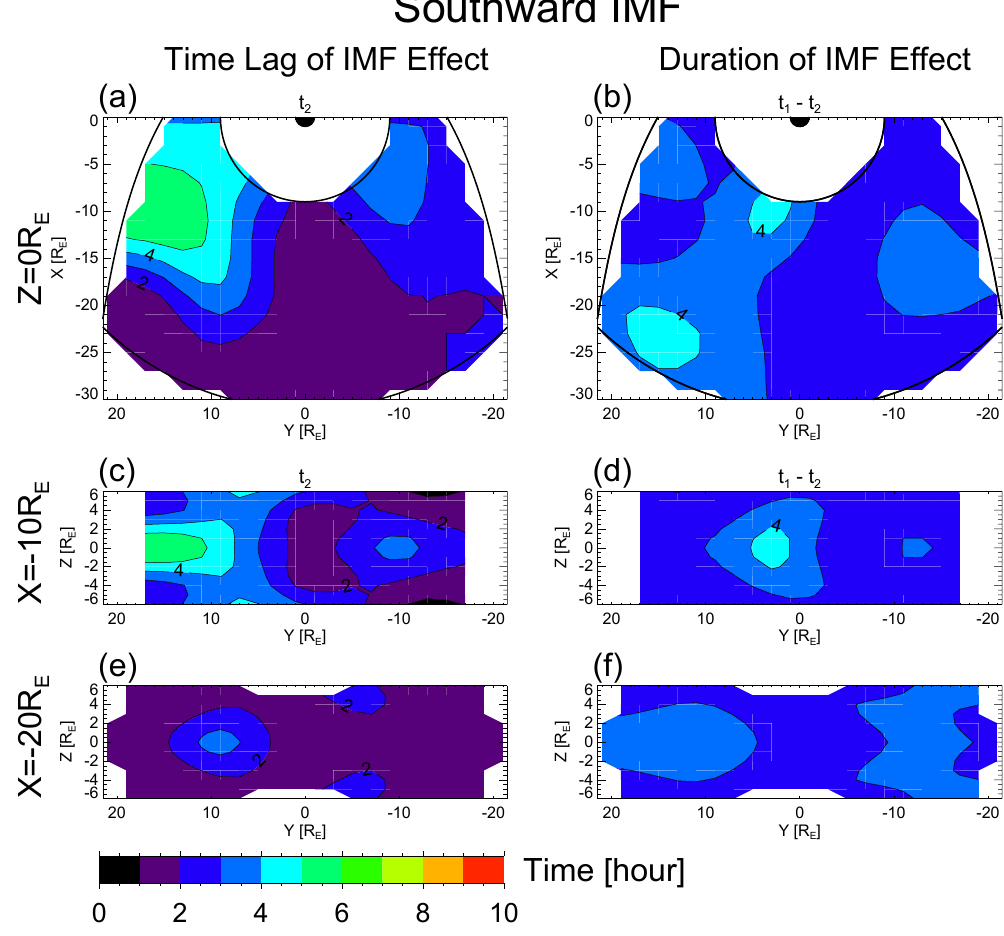
Fig. 9. Distributions of time lag and duration of IMF B z effect for southward IMF condition. Format is the same as Fig. 8.